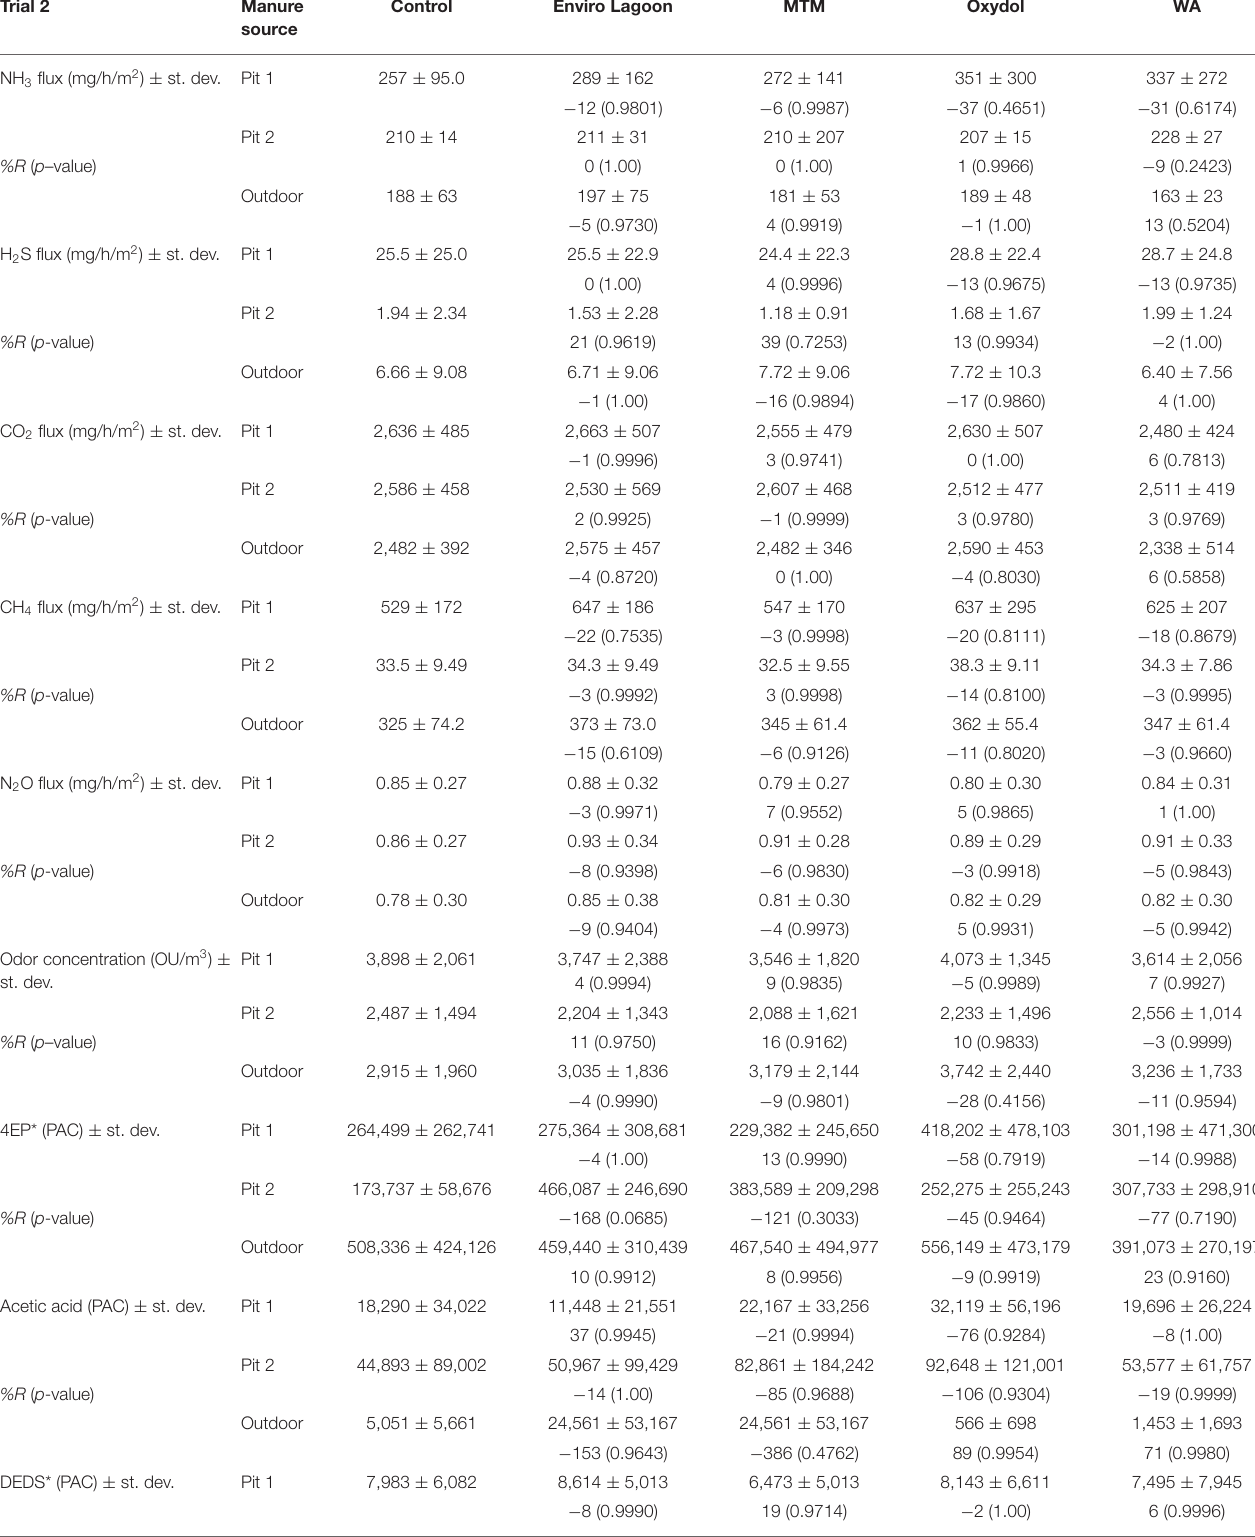
TABLE 5 | Trial 2-comparison of gaseous emissions from each of the three manure sources (farms) with their standard deviations. Trial